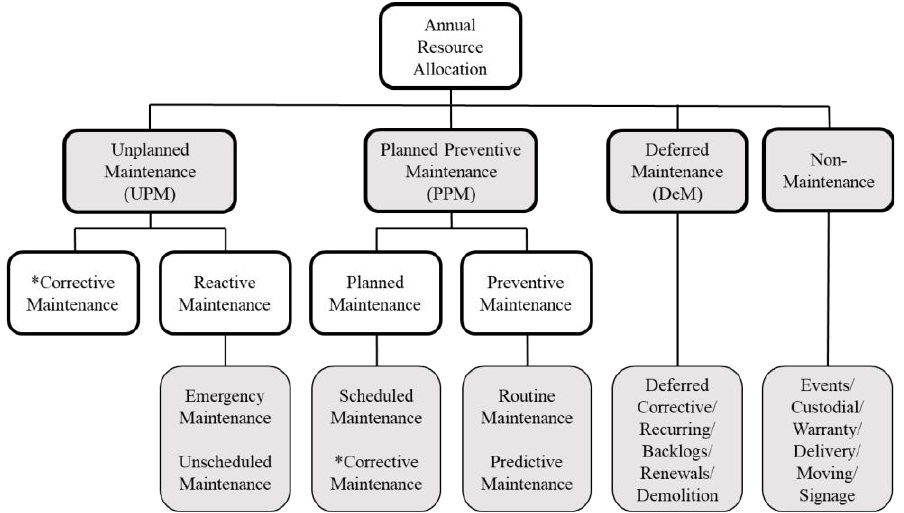
Figure 1. Hierarchical structure of facility management [1].